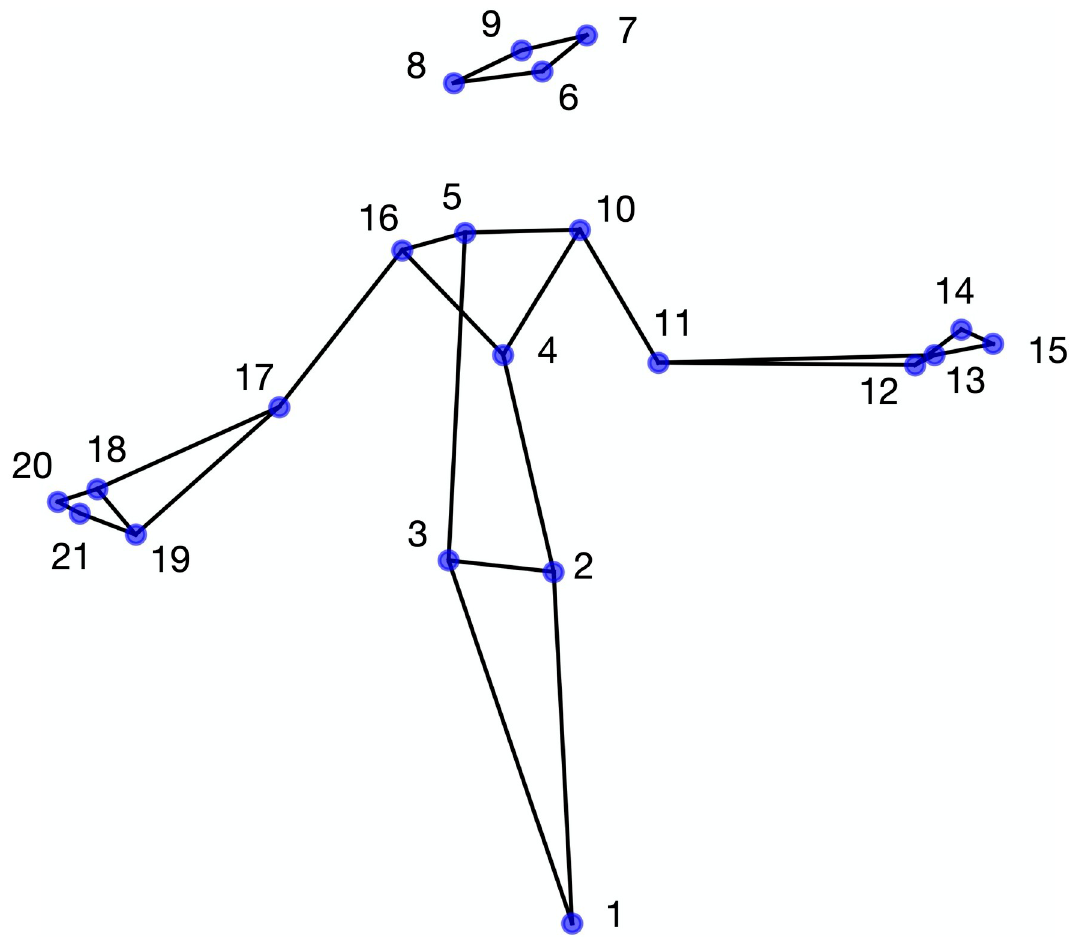
Fig 1. The 21 upper-body markers taken from the motion capture corpus.